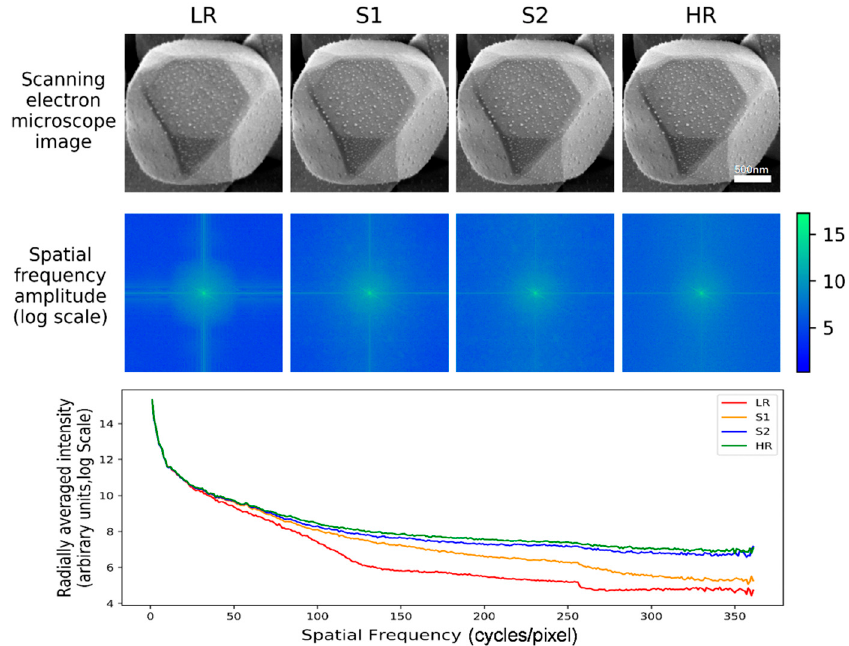
Figure 5. Spatial frequency analysis. Top: The AgCl@Ag example of the super-resolution network input images (LR) compared to stage one, stage two output images and the ground truth (HR) images. Middle: spatial frequency distributions of the four images on the top. Bottom: the plot of radially-averaged intensity of the above distributions.